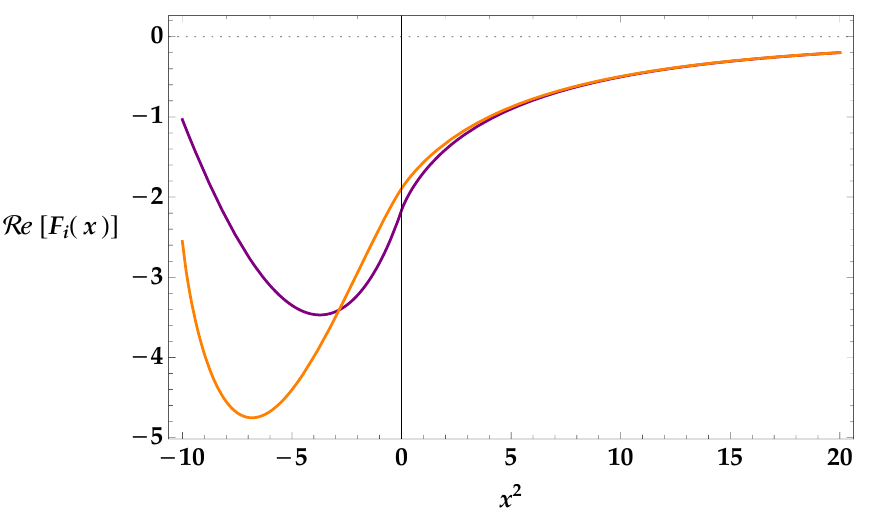
Figure 1 . Real parts of the bosonic thermal function F b ( x ) (purple curve) and the fermionic thermal function F f ( x ) (orange curve) are plotted over x 2 = m 2 =T 2 . When x 2 (cid:21) 0, F b and F f are both real and the absolute values of F b and F f decrease monotonically with increasing x 2 . Note that F b and F f generally become complex functions when x 2 < 0 (i.e., as mass-squared turns